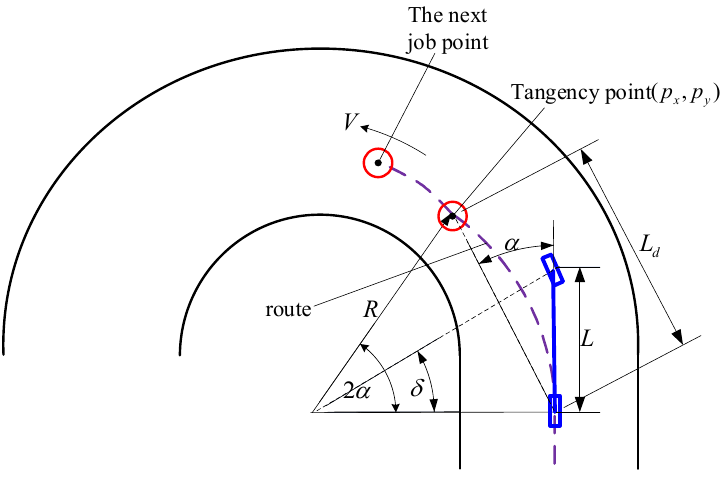
Figure 9. A Schematic diagram of the simplified two-round model. Figure 9. The steering gear controls the steering mechanism movement.